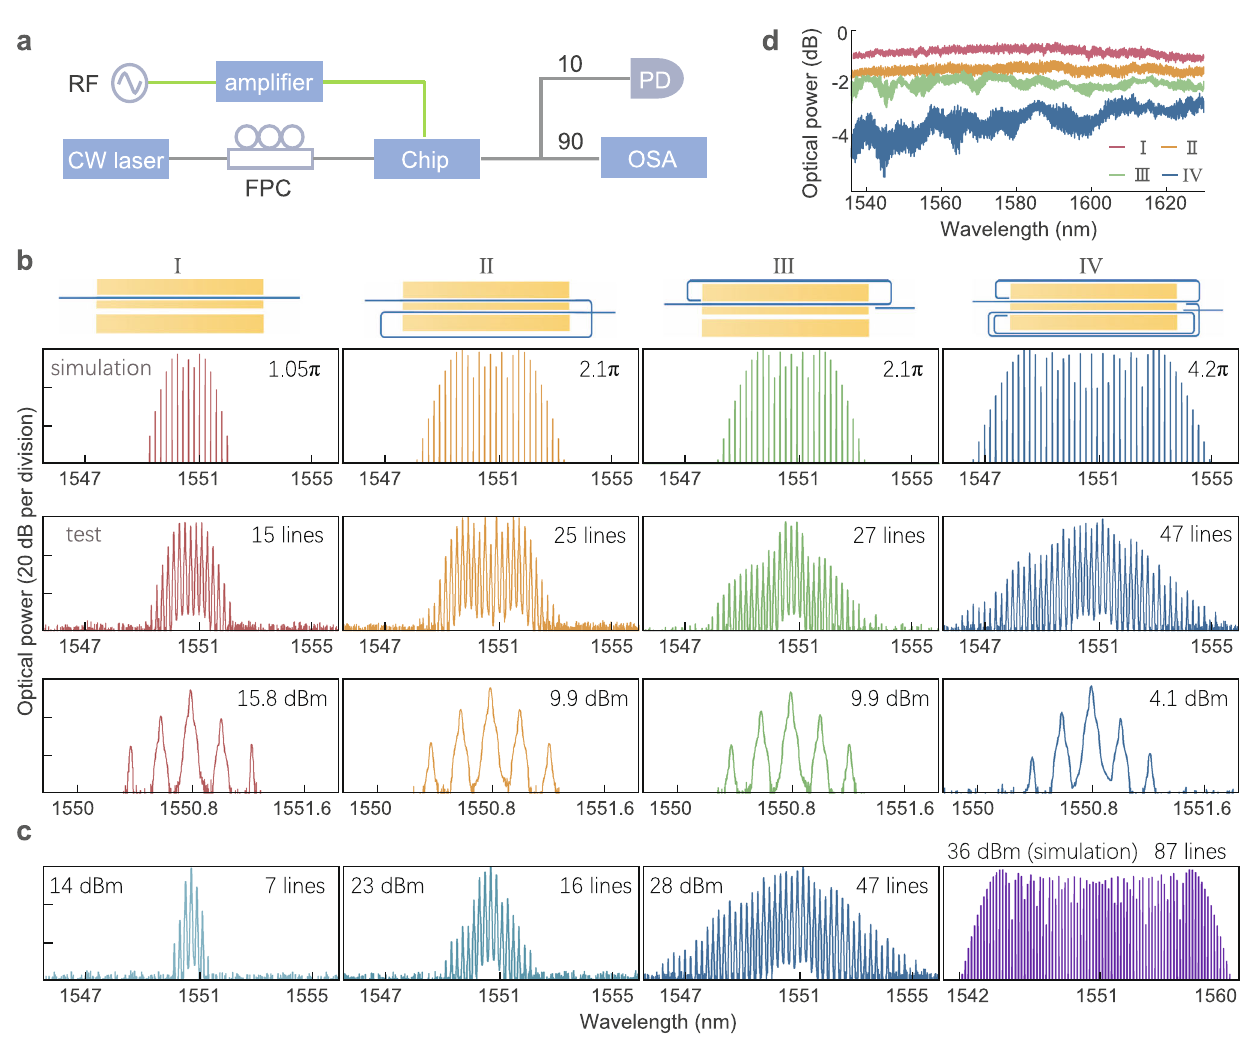
Fig. 3 Power-ef fi cient broadband on-chip electro-optic (EO) comb generation. a Experimental setup. b Optical frequency comb spectra generated from different types of EO comb generators. Top row: schematics of the four device types; middle two rows: simulated and measured EO comb spectra at the same radio-frequency (RF) drive power of 28 dBm for the four devices; bottom row: measured EO comb spectra with similar span at different RF drive powers for the four devices. c Comb spectra evolution at increasing RF driving power levels (14-28dBm, measured; 36 dBm, simulated) for the quadra-pass device. d Optical transmission spectra of the four different EO comb